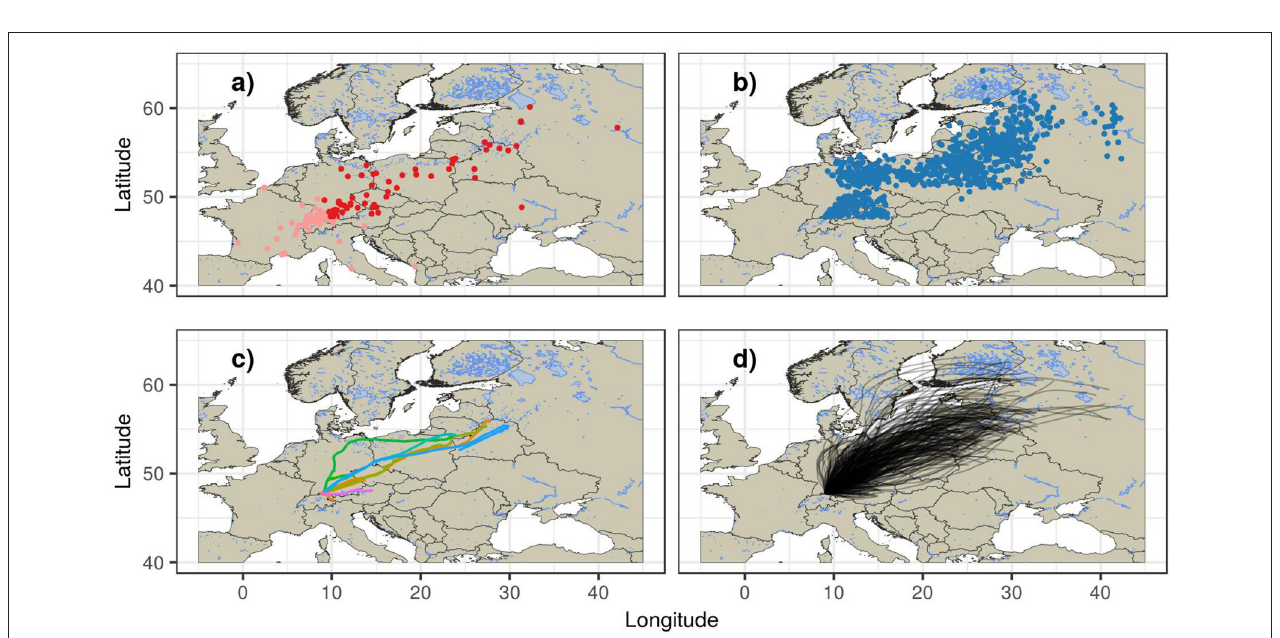
FIGURE 2 | Migration of mallards from the Lake Constance region based on empirical and simulated ring recoveries and migration trajectories. Panel (a) shows empirical ring recoveries with those relevant for spring migration in dark red, (b) shows 1,000 simulated destination locations for spring migrating mallards, (c) shows the empirical spring migration routes of mallards equipped with a GPS-GSM transmitter, and (d) shows 500 simulated spring migration trajectories.